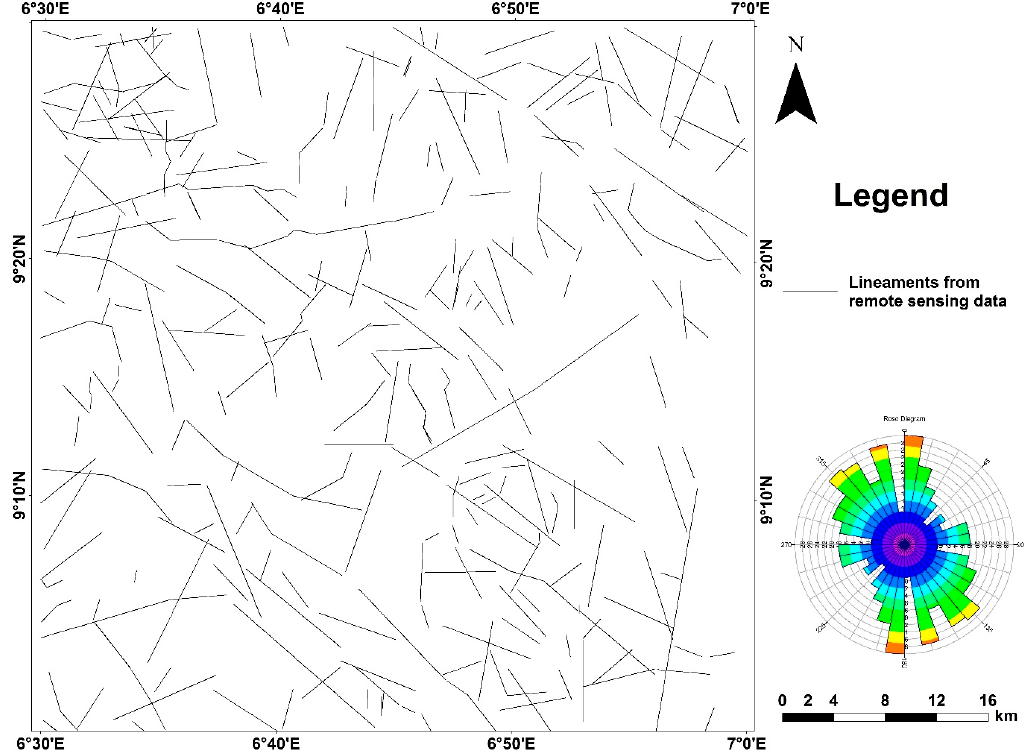
Figure 4. Lineaments extracted from edge enhanced Band 5 of Landsat ETM+ and SRTM DEM of Paiko Sheet 185 North Central Nigeria. The rosette diagram shows lineaments trending principally in the NW–SE and N–S directions.